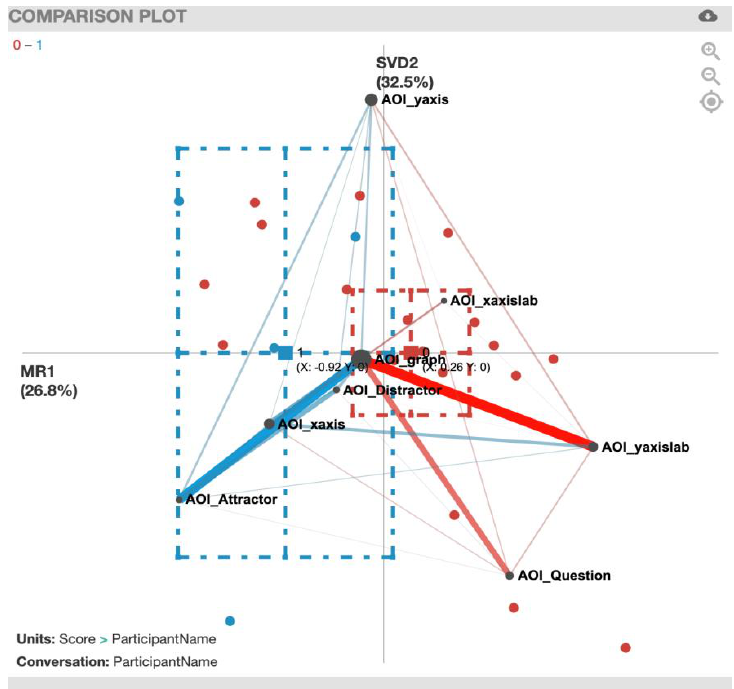
Figure 7. EcAreaQuant transitions with incorrect solvers (red) and correct solvers (blue). For the ENA plot of the PhyAreaQuant task (Figure 8), along the x -axis, a two-sample t -test assuming unequal variance (mean = 0.19, SD = 0.61, N = 20) indicated statistically significant differences at the alpha level =0.05 (mean = −1.30, SD = 0.58, N = 3; t(2.72) = −4.10, p = 0.03, Cohen’s d = 2.44). In contrast to the previously presented plots, this plot presents strong gaze transition correlations that are not connected to the AOI_graph, for example AOI_Question and AOI_xaxis for incorrect solvers (red). For a summary of the strong gaze transition correlations, see Table 6.